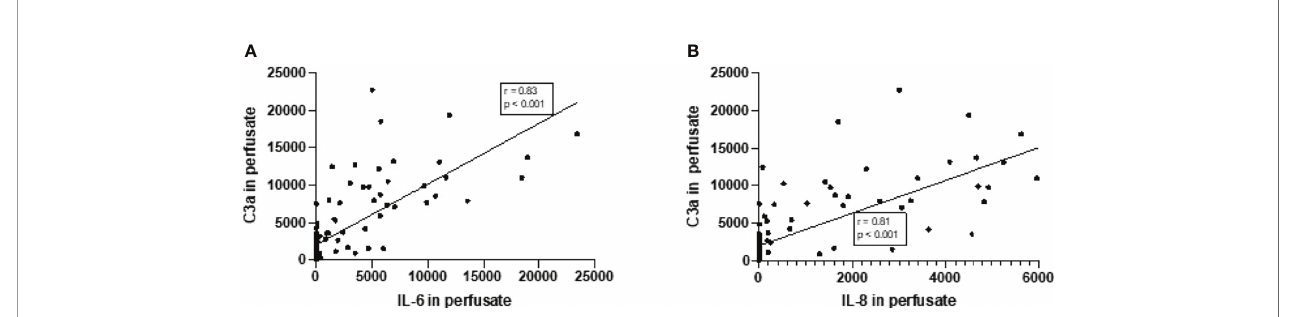
FIGURE 4 | Correlation between complement C3a perfusate levels and cytokine perfusate levels in porcine kidneys after 4 h of normothermic machine perfusion. Correlation between (A) complement C3a and IL-6 levels in perfusate and (B) correlation between complement C3a and IL-8 levels in perfusate after 4 h of NMP of porcine kidneys. Spearman ’ s correlation coef fi cient ( r ) and p -values are indicated. IL-6, interleukin-6; IL-8, interleukin-8; NMP, normothermic machine perfusion.